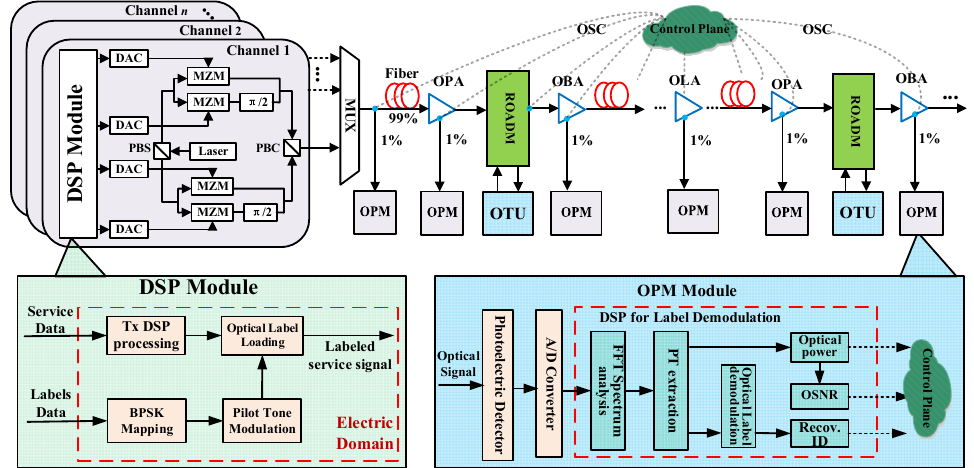
Figure 1. Schematic diagram of the optical-label enabled OPM scheme. (OTU: optical transponder unit, OPA: optical pre-amplifier, OBA: optical boost amplifier, OLA: optical line amplifier, MZM: Mach-Zehnder modulator, PBC: polarization beam combiner, PT: pilot tone, OSC: optical supervising channel).